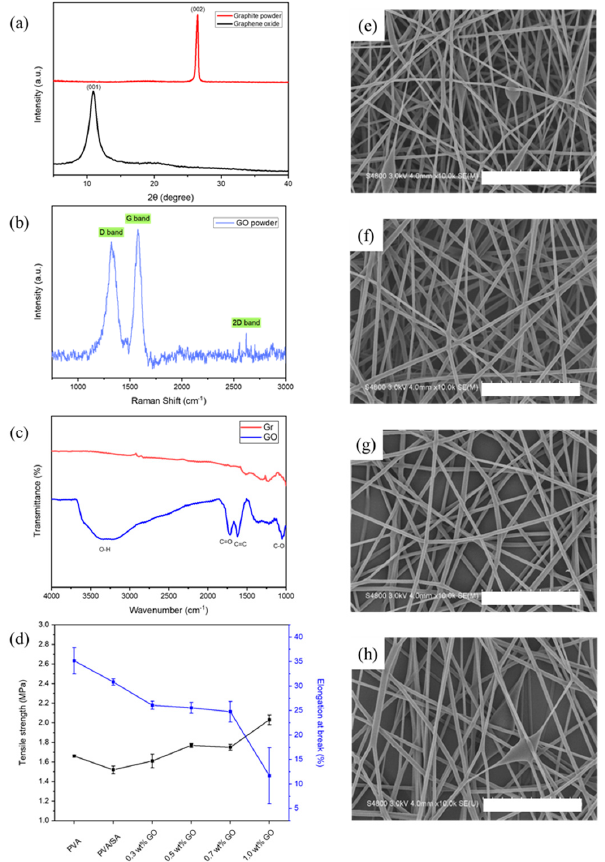
Figure 2. The testing results of ( a ) XRD, ( b ) Raman, and ( c ) FTIR patterns of graphene oxide (GO) via the Hummers’ method. ( d ) The tensile strength and elongation during the breaking of PVA/SA/GO nanofibers. The SEM image of PVA/SA/GO nanofibers with varying GO concentrations of ( e ) 0.3 wt%, ( f ) 0.5 wt%, ( g ) 0.7 wt%, and ( h ) 1.0 wt%, respectively. (The scale bar in the SEM image is 5 µ m). The curve of Raman spectroscopic analysis for the GO sample is demonstrated in Figure 2b. The main characteristic peaks of GO specimens were associated with the D- band, G-band, and 2D-band fingerprints corresponding to their wavelengths located at 1330 cm − 1 , 1580 cm − 1 , and 2670 cm − 1 , respectively. The existence of the